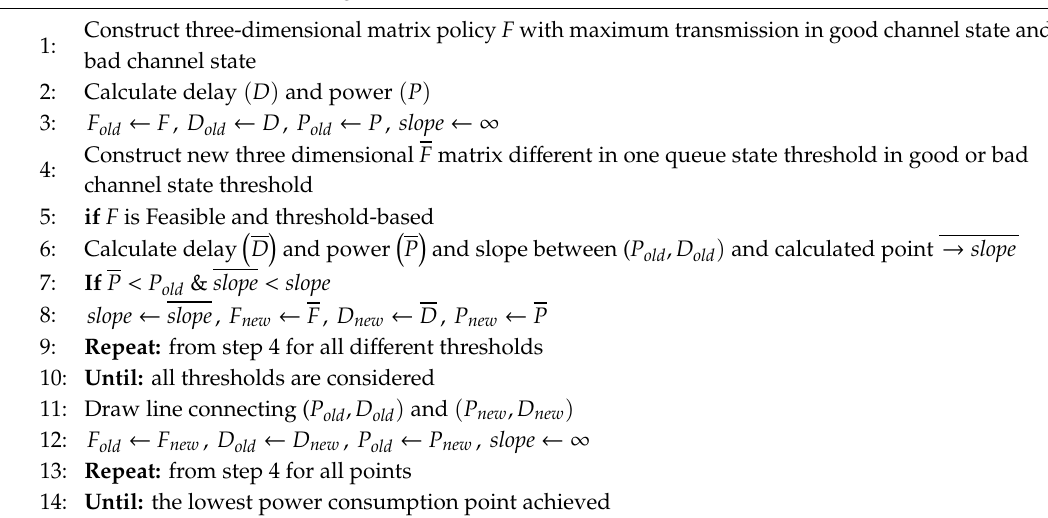
Algorithm 1 Enhanced Iterative